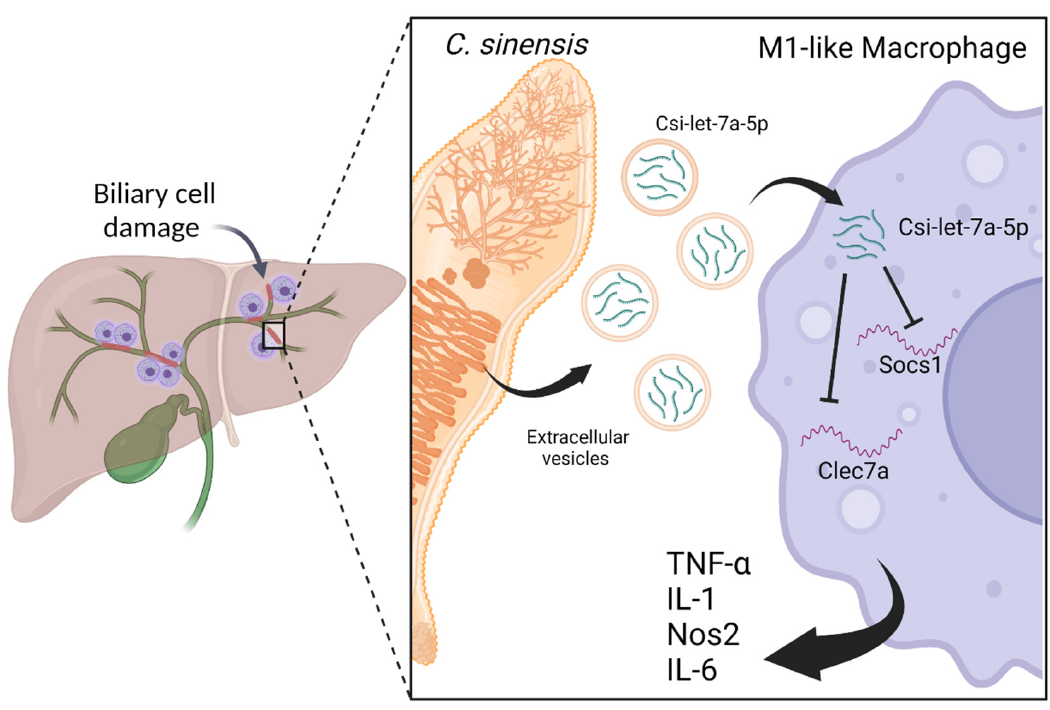
Figure 4. C. sinensis worms can release extracellular vesicles with miRNA cargo such as Csi-let-7a-5p. This miRNA is delivered to host macrophages, binds molecular targets inhibiting genic expression, and promotes polarization of these immune cells. Csi-let-7a-5p packaged in extracellular vesicles supports the accumulation of M1-like macrophages in the liver, which can lead to a proinflammatory microenvironment that has been connected to damage and proliferation of biliary cells. Created using